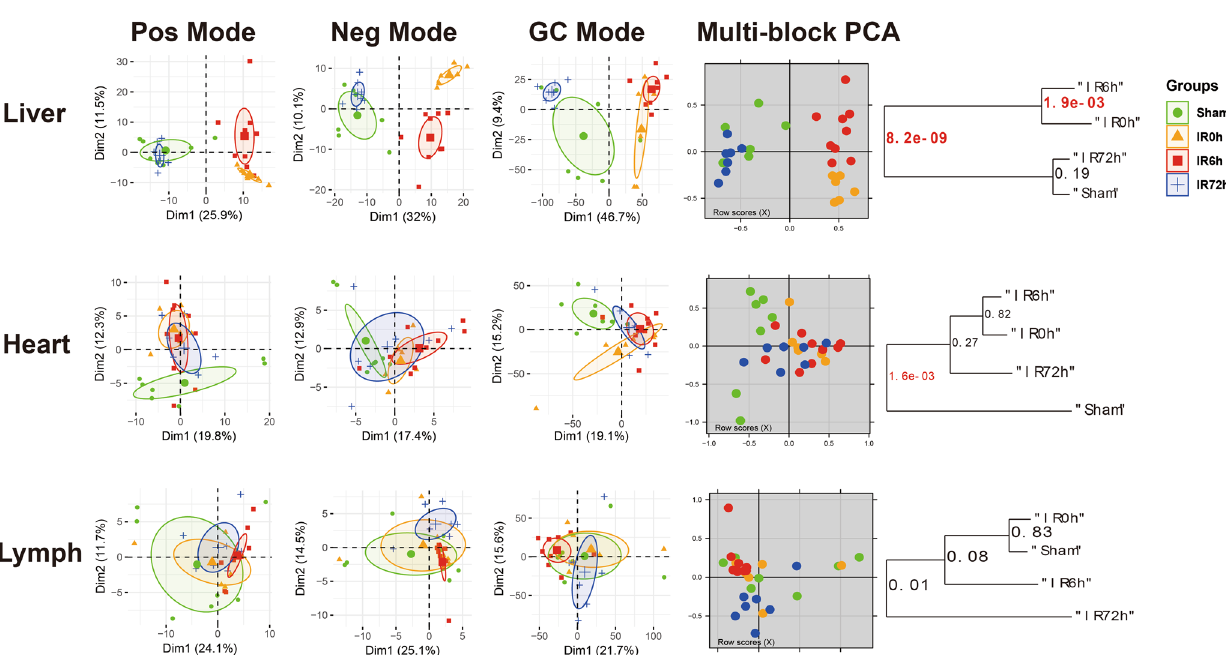
Fig. 2 IIR affected metabolomic pro fi les of intestinal and remote organs that showed three distinct patterns during IIR (selected representatives: liver, heart, lymph). The fi rst three columns are the principal component analysis (PCA) score plots derived from the LC/MS (ESI + ), LC/MS (ESI − ), and GC/MS metabolite data, respectively. And the fourth column illustrates the multiblock principal component analysis of the data fusion of LC/MS and GC/ MS. Plots in the fi fth column are metabolic tree diagrams corresponding to the multiblock-PCA score plots using Mahalanobis distances, with p values for the null hypothesis shown at each branch. The fi rst two principal components (Dim1 and Dim2) were estimated as suf fi ciently well represented by the principal plan generated by each PCA. The value of p < 0.01 was considered to be signi fi cantly different, which were marked in red. Green symbols correspond to Sham groups, yellow symbols to IR0h groups, red ones to IR6h groups and blue ones to IR72h groups. Pos mode: liquid chromatography- mass spectrometry (ESI + ); Neg mode: liquid chromatography-mass spectrometry (ESI − ); GC mode: gas chromatography-mass spectrometry. Shown here are representatives of three patterns we have identi fi